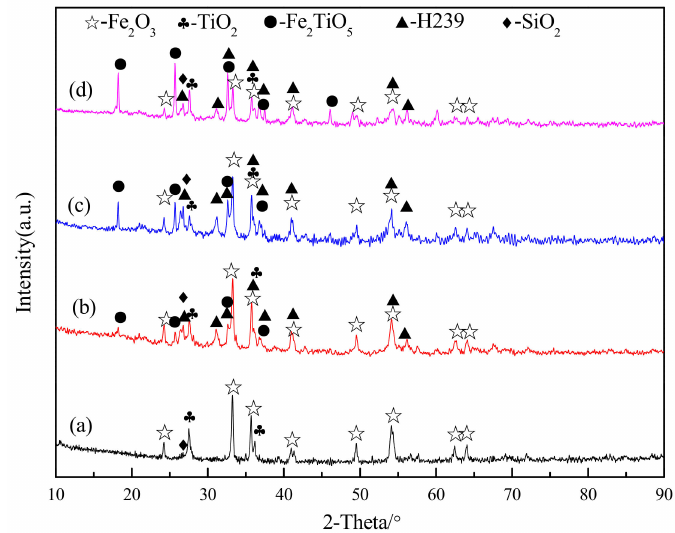
Figure 5. Combination of TiO 2 and Fe 2 O 3 for ( a ) ilmenite A0 oxidized at 800 ◦ C for 60 min, ( b ) il- menite A0 roasted at 900 ◦ C for 30 min after it was oxidized at 800 ◦ C for 60 min, ( c ) ilmenite A0 roasted at 900 ◦ C for 60 min after it was oxidized at 800 ◦ C for 60 min, and ( d ) ilmenite A0 roasted at 900 ◦ C for 450 min after it was oxidized at 800 ◦ C for 60 min.